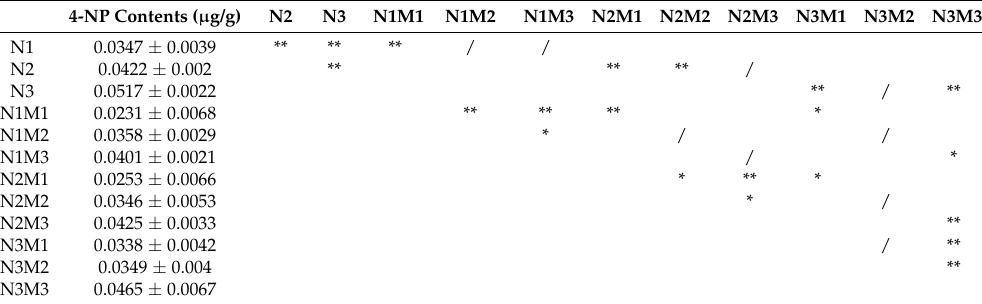
Table 4. Statistical analysis of 4-NP contents in liver at Day 15.